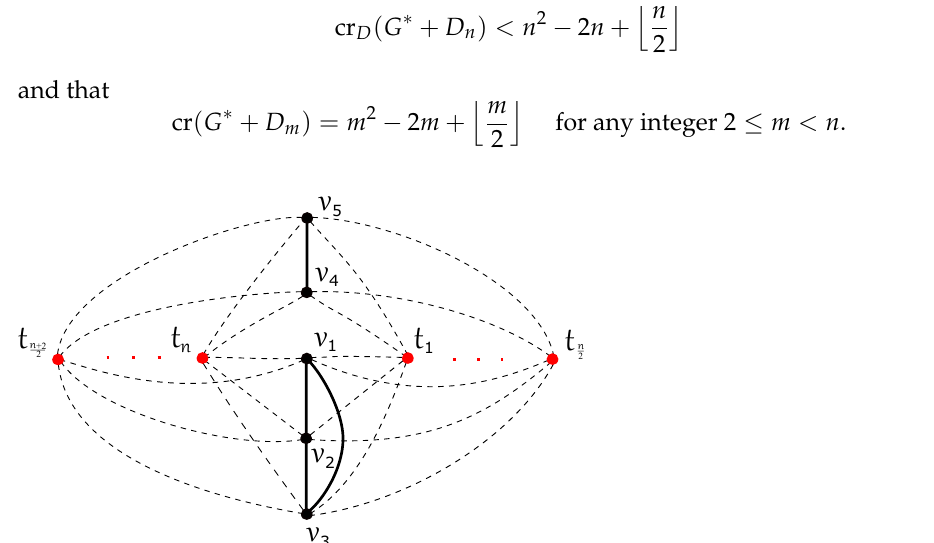
(cid:4) n (cid:5)(cid:4) n − 1 (cid:5) + (cid:4) n (cid:5) crossings for n even, n ≥ 2. 2 2 2